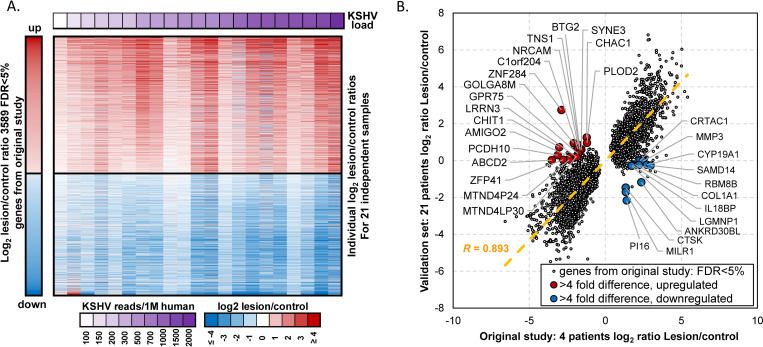
Correlation of cellular gene expression in KS lesion/control between previous and current study.(A) Heatmap of lesion/control difference in expression from 21 new sample pairs for 3589 up- or down-regulated cellular genes reported in the previous study. (B) Correlation of cellular genes differences between KS lesion vs control reported in the previous study versus current study. Top changes for 30 up- and down-regulated genes (>4-fold change) unique to the current study are highlighted in red and blue, respectively. Correlation line is shown by dotted orange line. FDR–False discovery rate. KSHV–Kaposi’s sarcoma (KS)-associated herpesvirus.